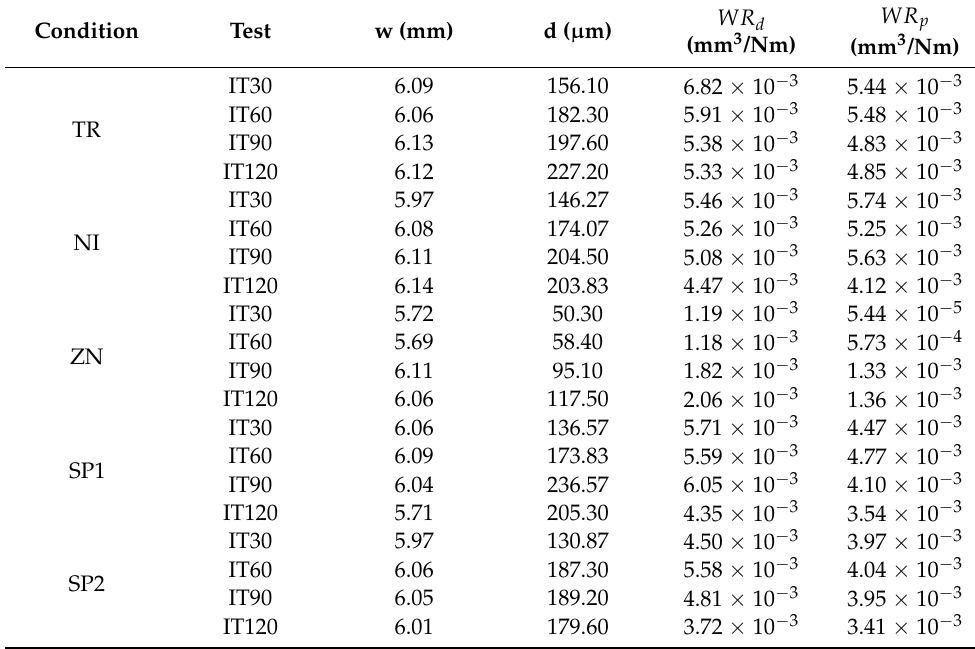
Table 10. Variation of w , d , WR d , and on the pins WR p at 2 Hz sliding frequency.